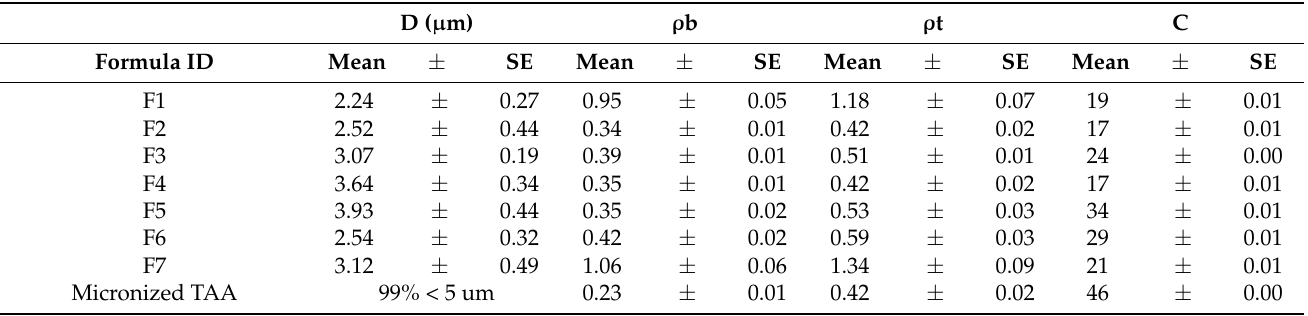
Table 2. Physical examination results of TAA spray-dried products without blowing agent in com- parison with micronized